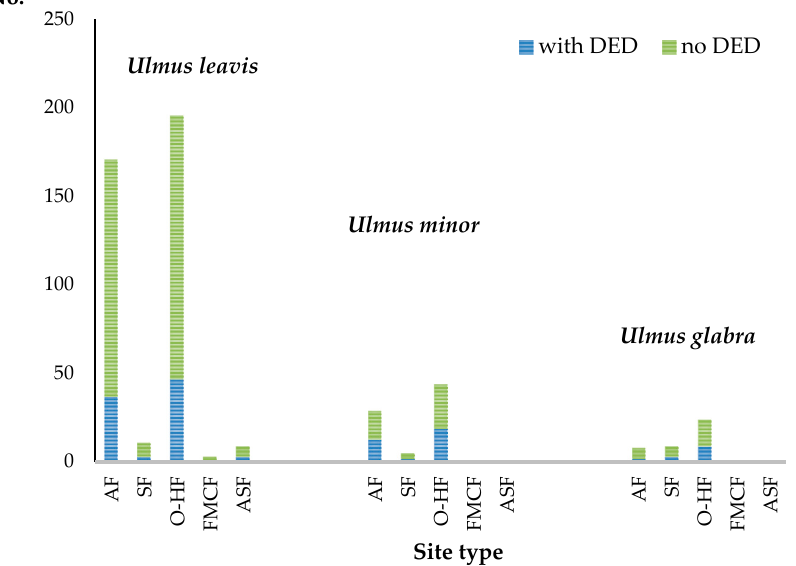
Figure 6. Occurrence of Dutch Elm Disease (DED) symptoms in the study area. AF—alluvial forest, SF—slope forest, O-HF—oak-hornbeam or similar forest, FMCF—fresh mixed coniferous forest, ASF—alder swamp forest.